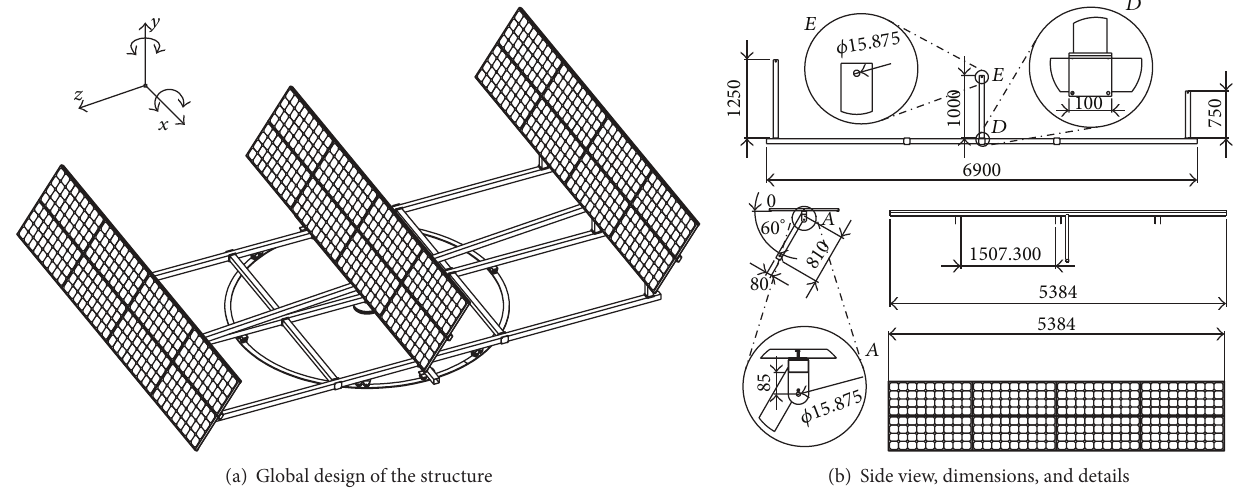
Figure 4: Mechanical design based on the SolidWorks computational